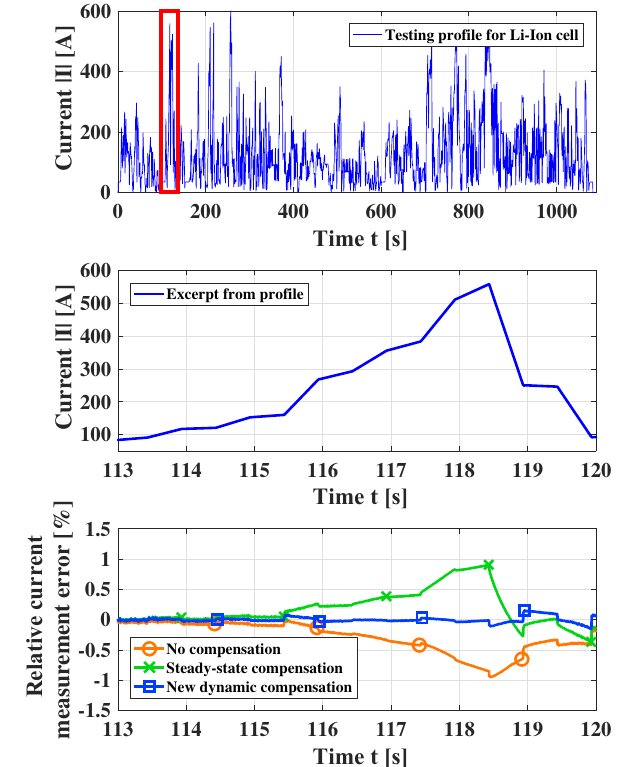
Figure 10. Realistic testing profile for lithium-ion cells (top: full profile; middle: excerpt) and associated relative current measure- ment errors (bottom).